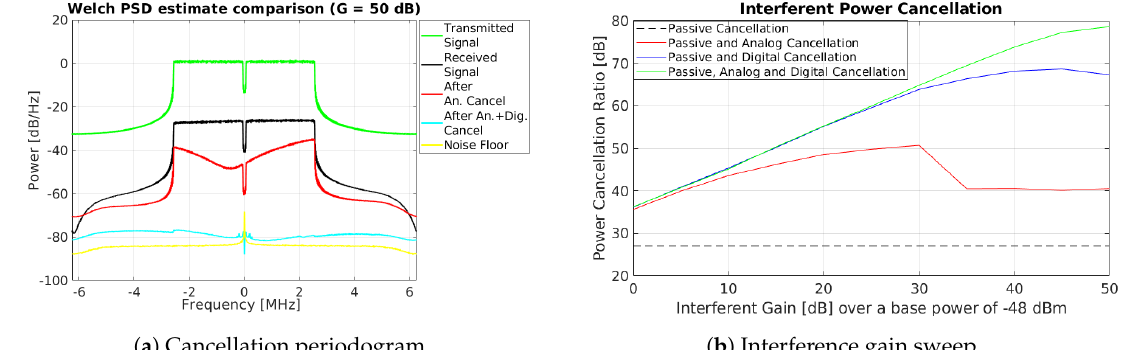
Figure 3. Cancellation